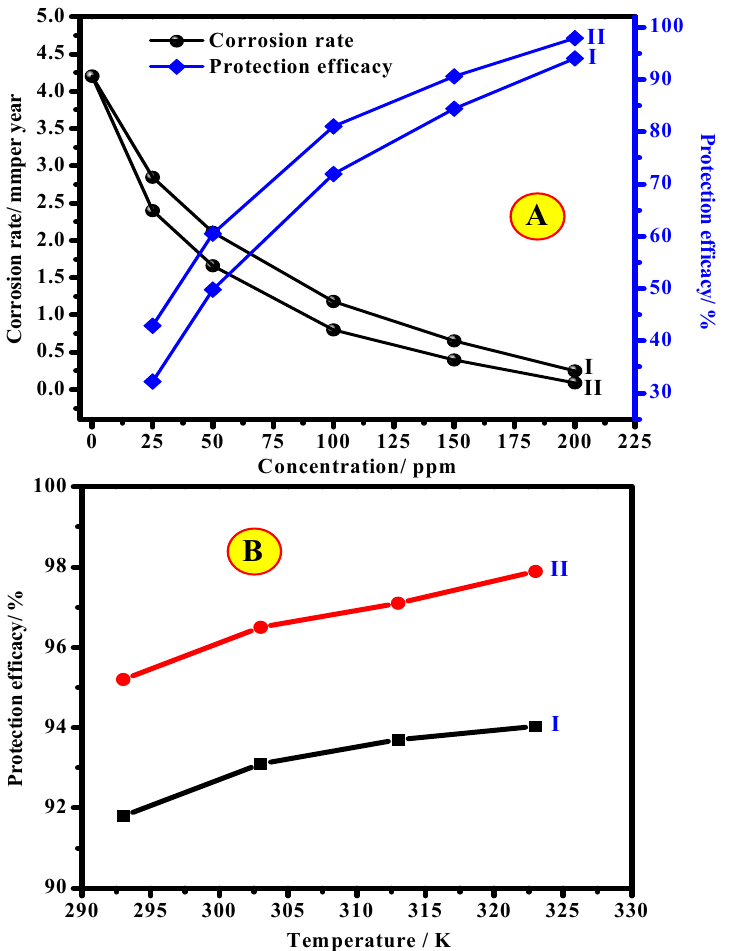
Figure 5. Change of corrosion rate and protection capacity for SS316 alloy with (I) NCC and (II) CEL concentrations at 50 °C ( A ) and effect of temperature on the protection capacity of SS316 alloy in 2.0 M HCl containing 200 ppm of (I) CEL and (II) NCC ( B ).